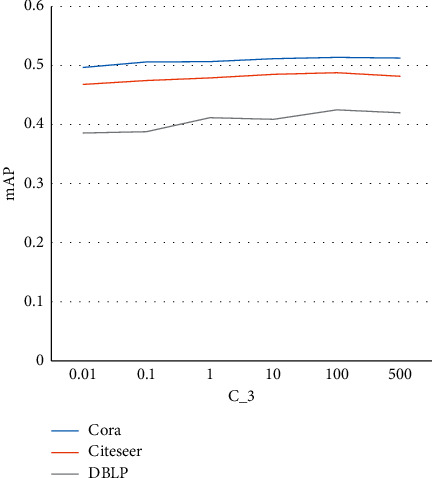
Sensitivity analysis of C3.